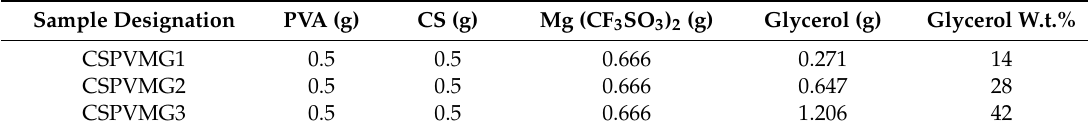
Table 1. The designation and composition for the glycerol plasticized of PVA:CS:Mg(CF 3 SO 3 ) 2 systems. Sample